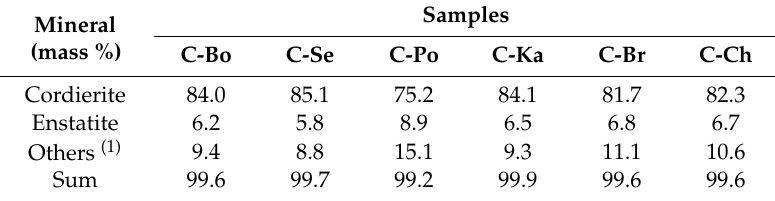
Table 6. Quantitative amounts of minerals in ceramic samples determined using CQMA method. Mineral (mass